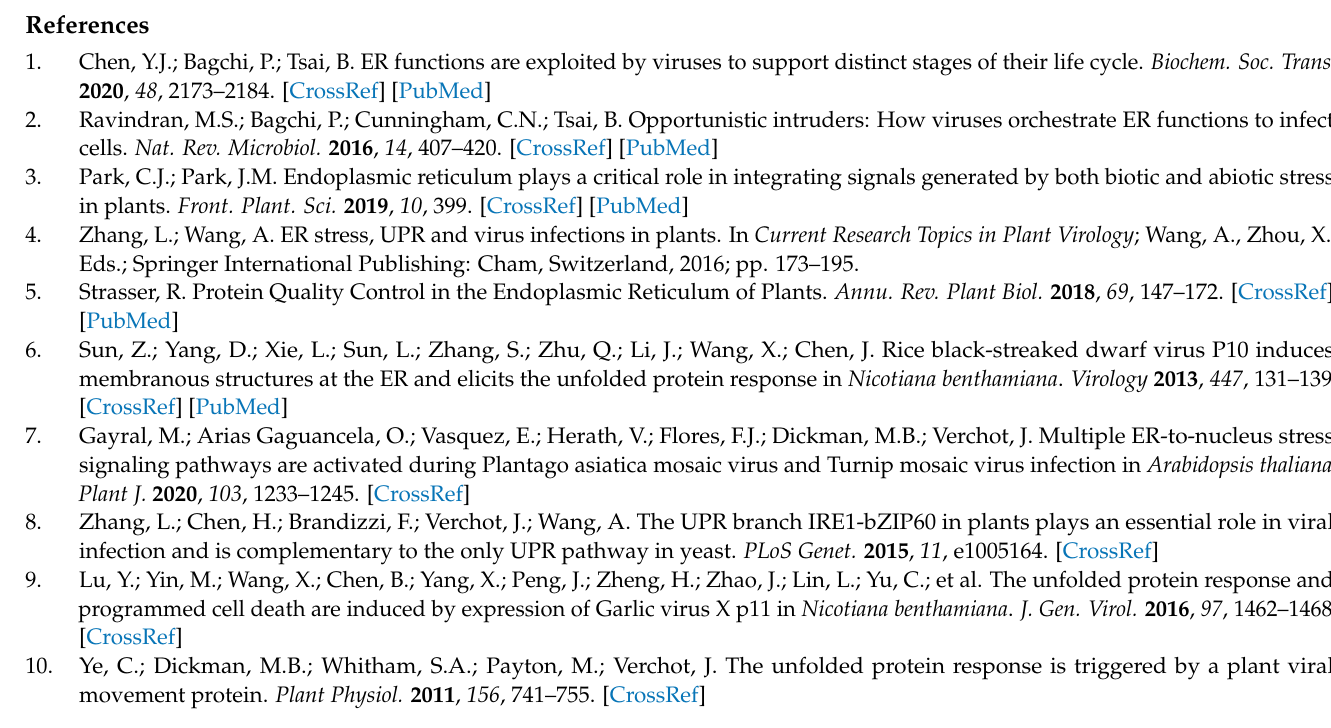
stack 1 for Figure 1C; Movie S4: V2-GFP-Z stack 2 for Figure 1C; Movie S5: GFP-V2-Z stack 1 for Figure 1C; Movie S6: GFP-V2-Z stack 2 for Figure